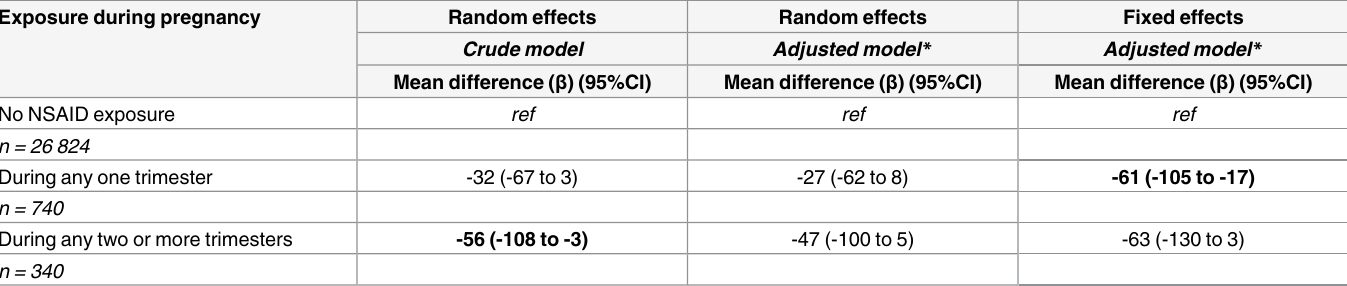
Table 4. Associations of ibuprofen with birth weight according to duration of exposure. All values are given in grams. Exposure during